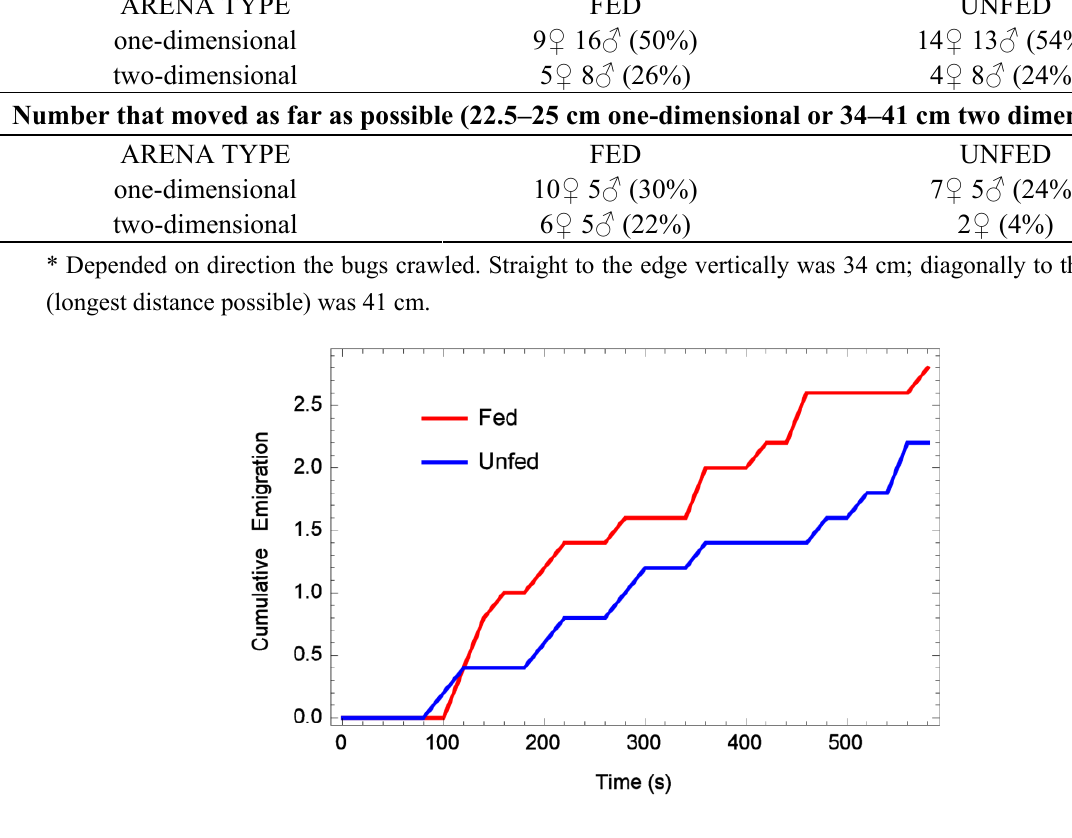
Figure 4. Mean cumulative emigration rates over time (bugs that reached the edge), one-dimensional